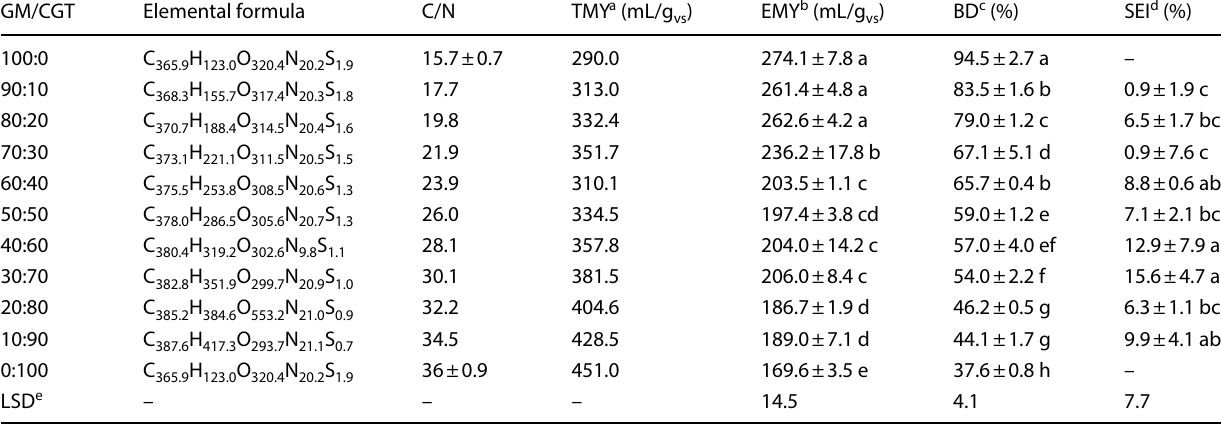
Each value is a mean ± SD from triplicates. The values across a column sharing the same letter are similar at α = 0.05 a Theoretical biomethane potential; for pure substrates, the value was adjusted according to the VS% after initial calculation from